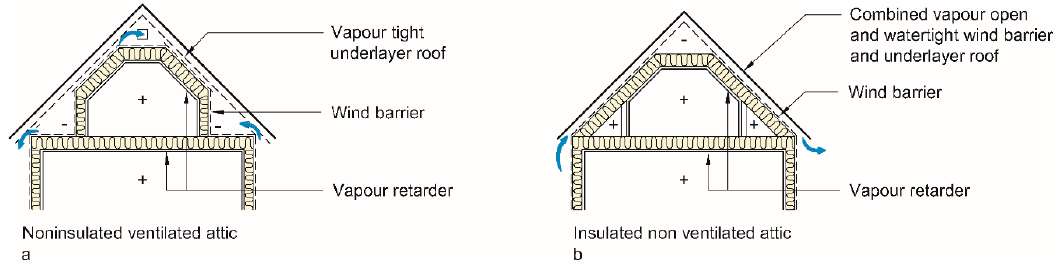
Figure 4. Roof Type D with heated rooms in part of the attic. Thermally insulated non-ventilated attic rooms ( a ) and thermally non-insulated, ventilated (from outside) attic rooms ( b ). Further developed from [13].